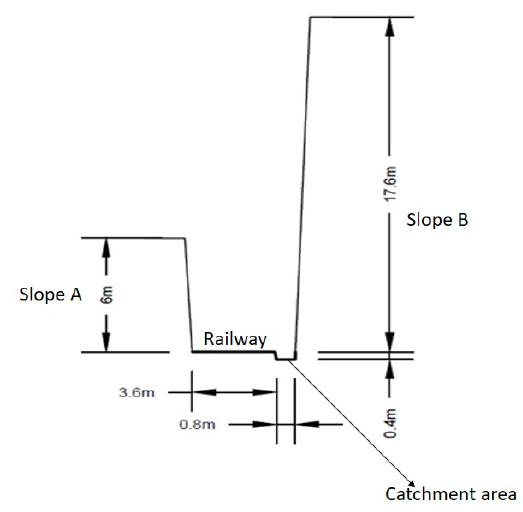
Figure 6. Sketch of the railway slopes.